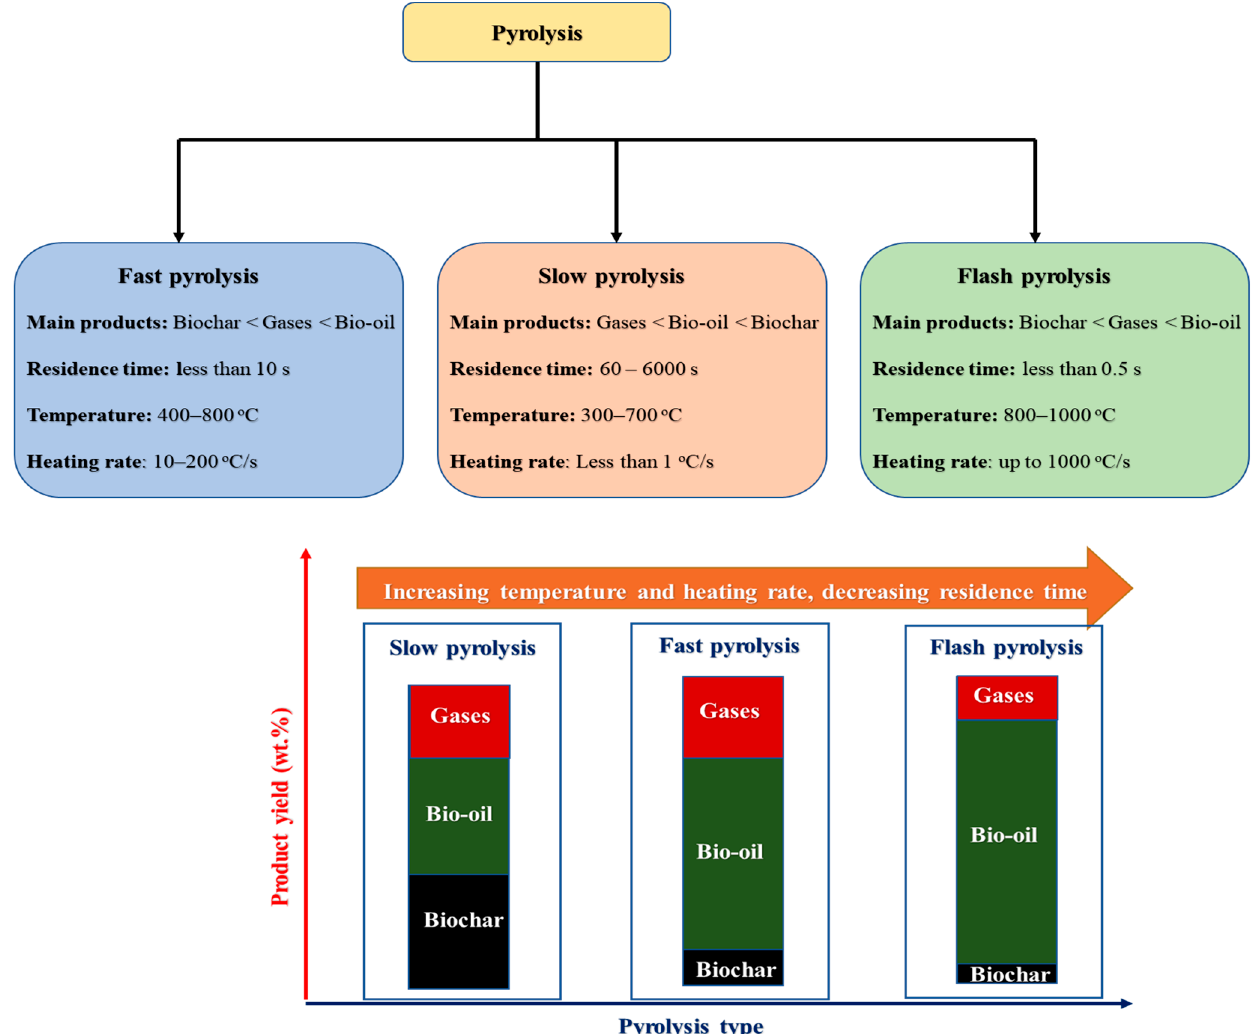
Figure 3. Overview of different types of pyrolysis. Data were obtained from Okolie et al. [8].